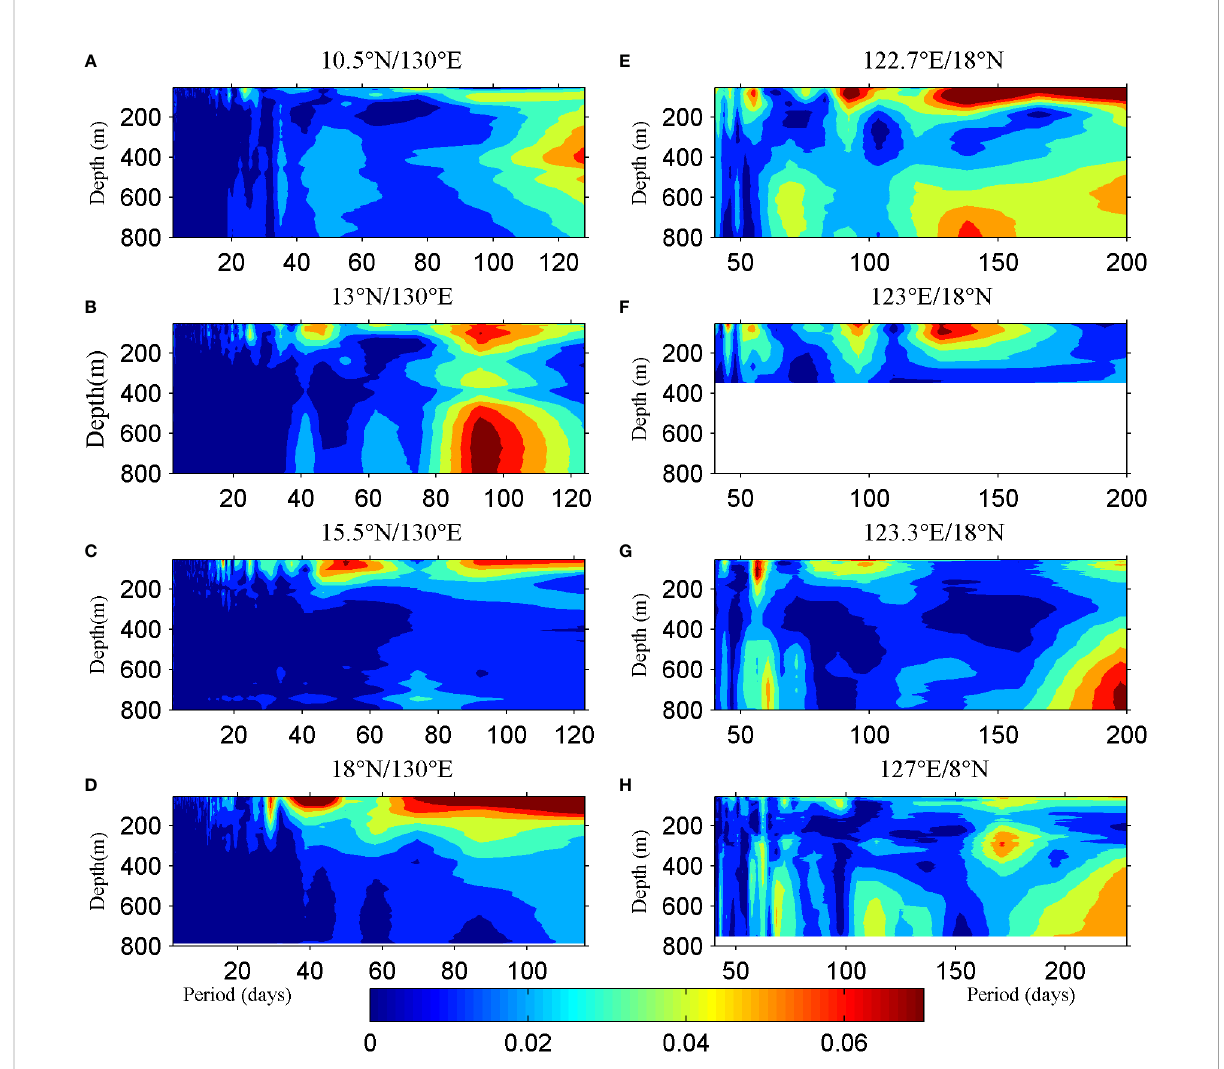
FIGURE 4 Power spectral density (PSD) of zonal velocities from ADCPs at (A) 10.5°N, (B) 13°N, (C) 15.5°N, (D) 18°N along 130°E and PSD of meridional velocities from ADCPs at (E) 122.7°E, (F) 123°E, and (G) 123.3°E along 18°N and (H) 127°E/8°N. Units are m 2 /(s 2 cycles per day